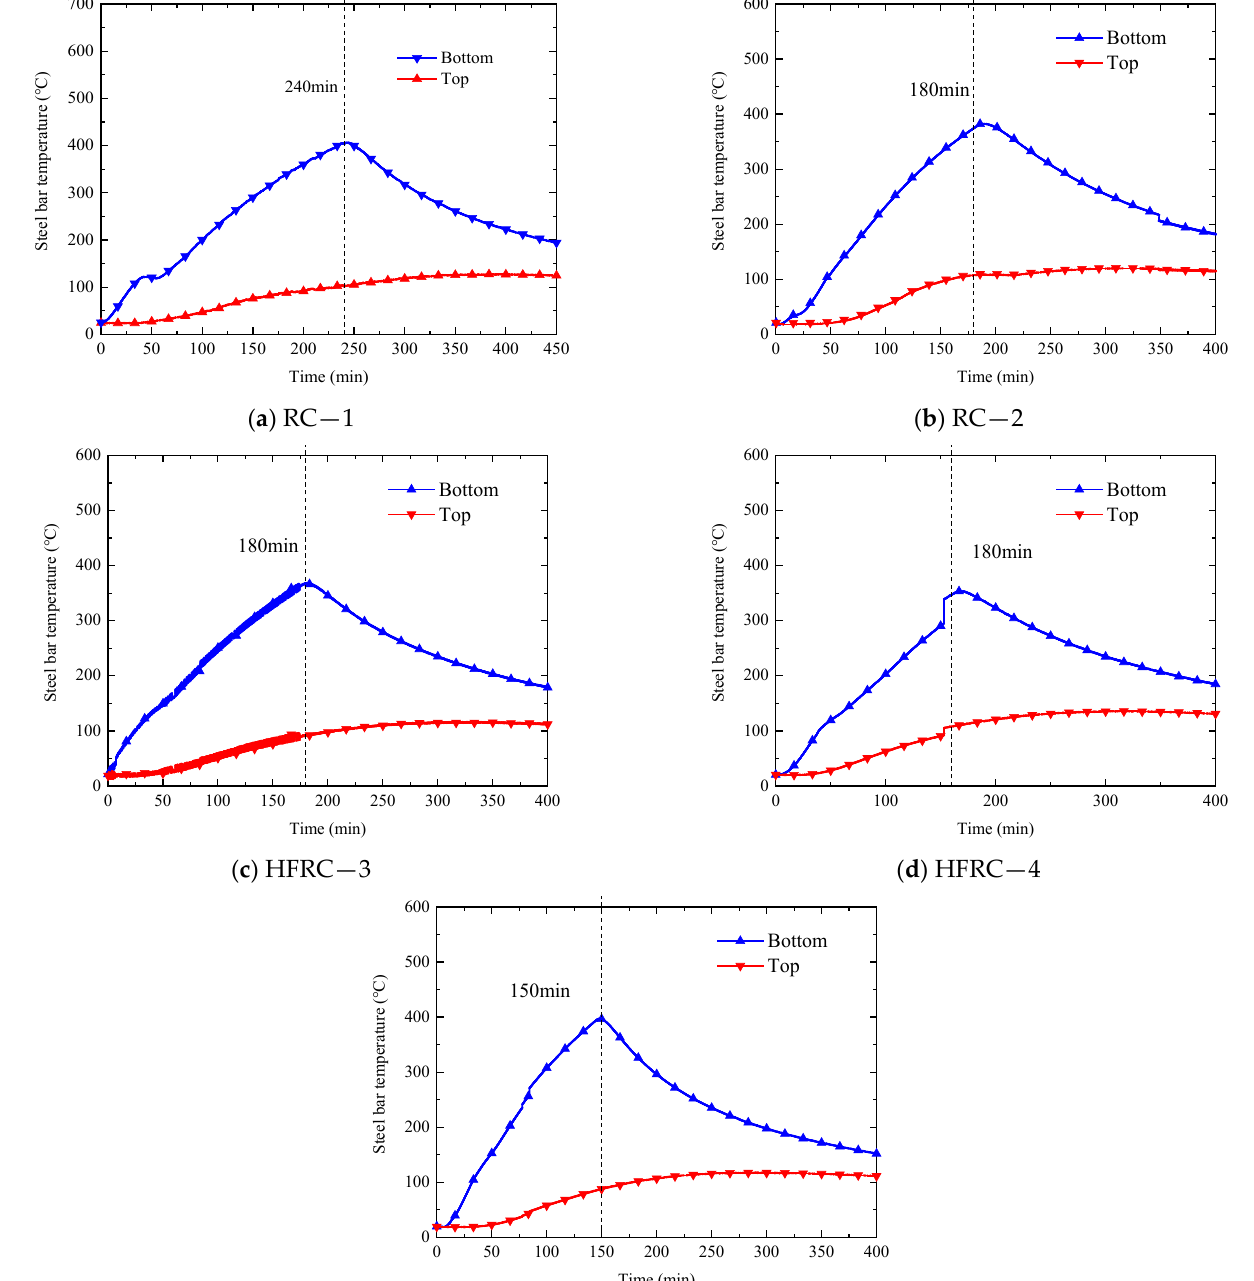
Figure 13. Time–temperature curves of segment steel bars: ( a ) RC—1; ( b ) RC—2; ( c ) HFRC—3; ( d ) HFRC—4; and ( e )